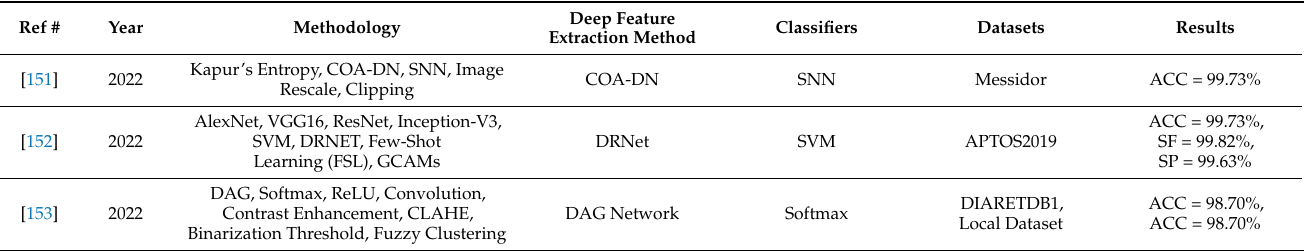
Table 6. Reported deep feature and classification techniques used in various reviewed